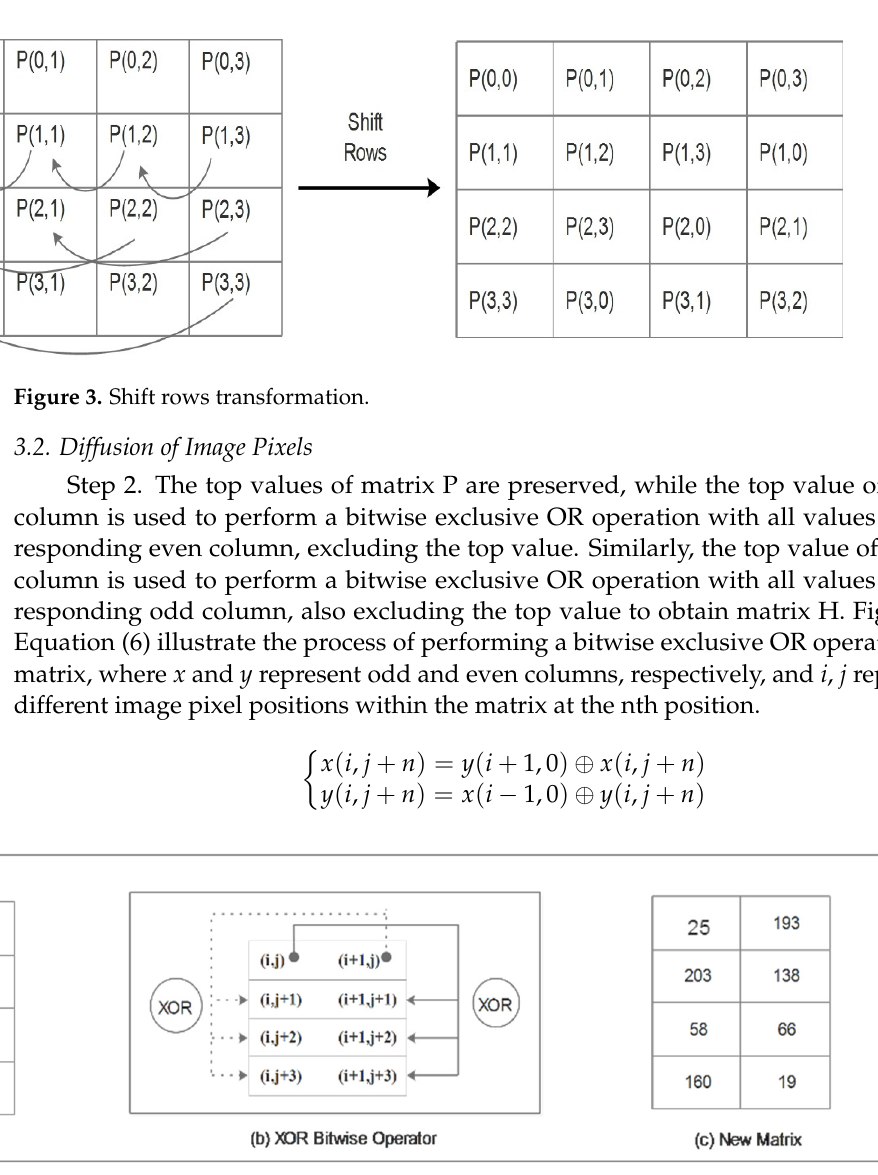
Figure 4. Diffusion process 1.